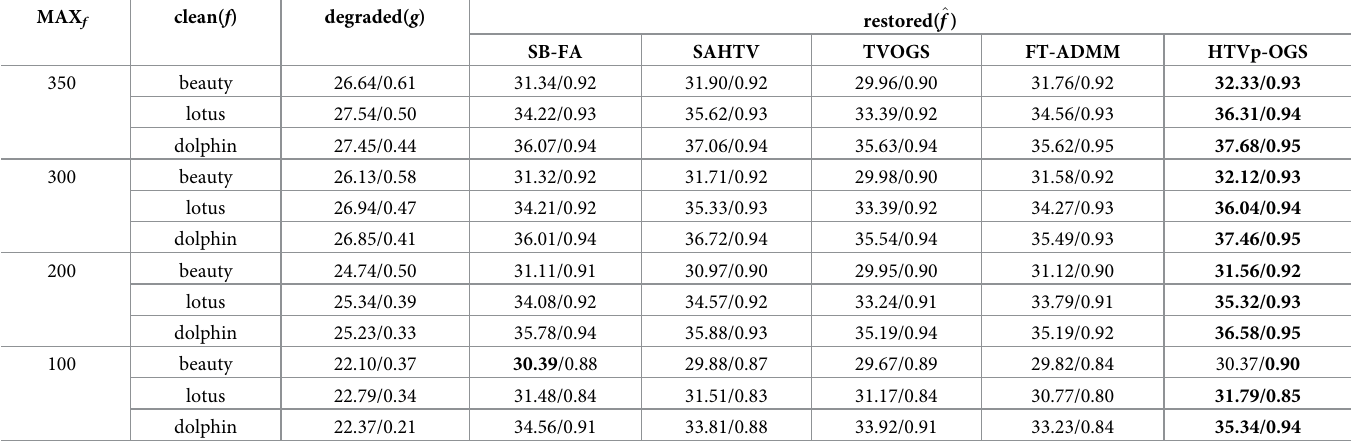
Table 3. The PSNR and SSIM values for the Poisson image restoration by different methods in the case of the motion blur with length 5 and angle 45˚. MAX f clean( f